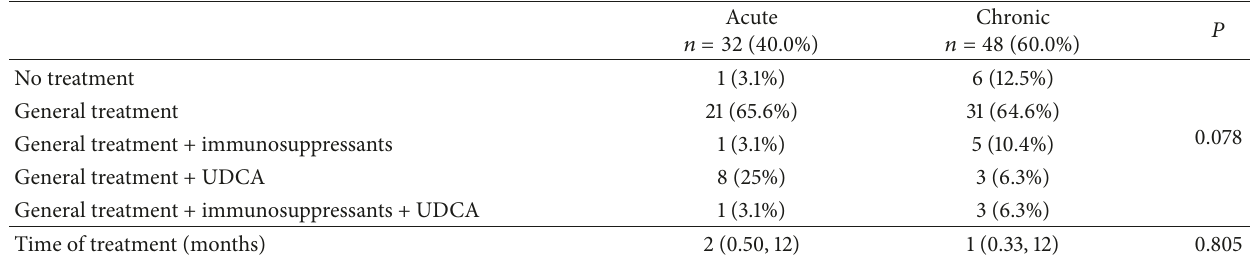
Table 4: Comparison of treatments between A-AIH and C-AIH before liver